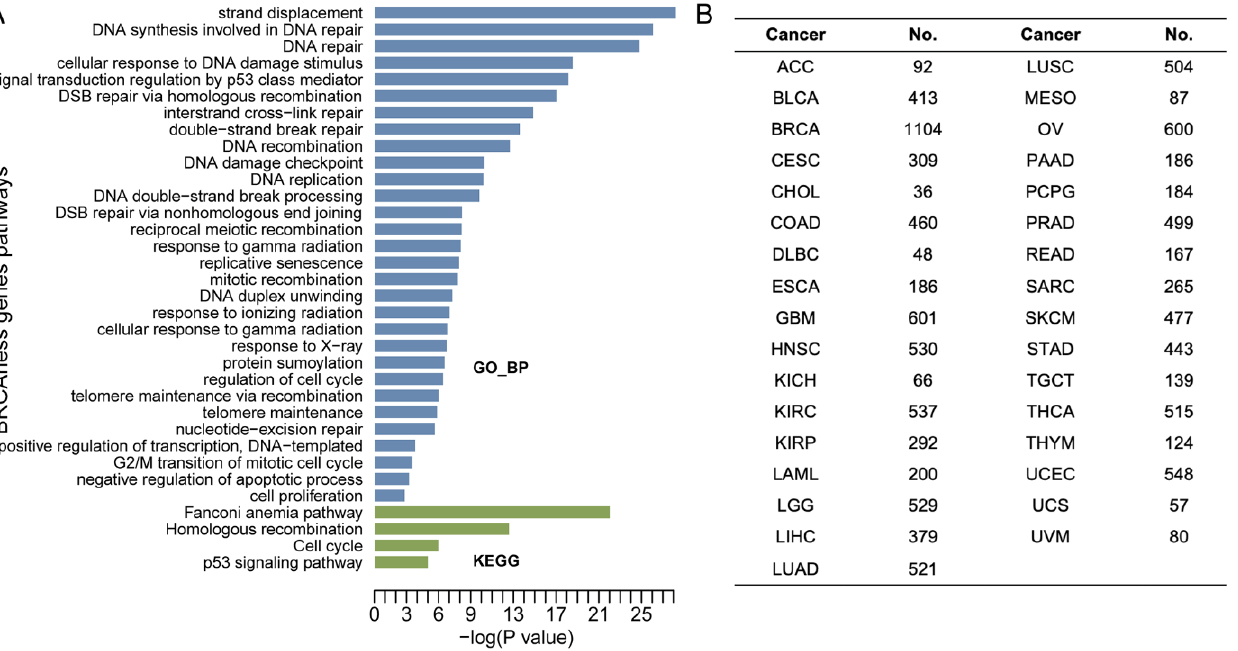
Figure 1. Scheme of the analysis. ( A ) Functional enrichment analysis for BRCAness genes. It shows the barplot for the top 30 significant GO functional enriched biological processes (BPs), and KEGG pathways. ( B ) The number of patients included each cancer type.